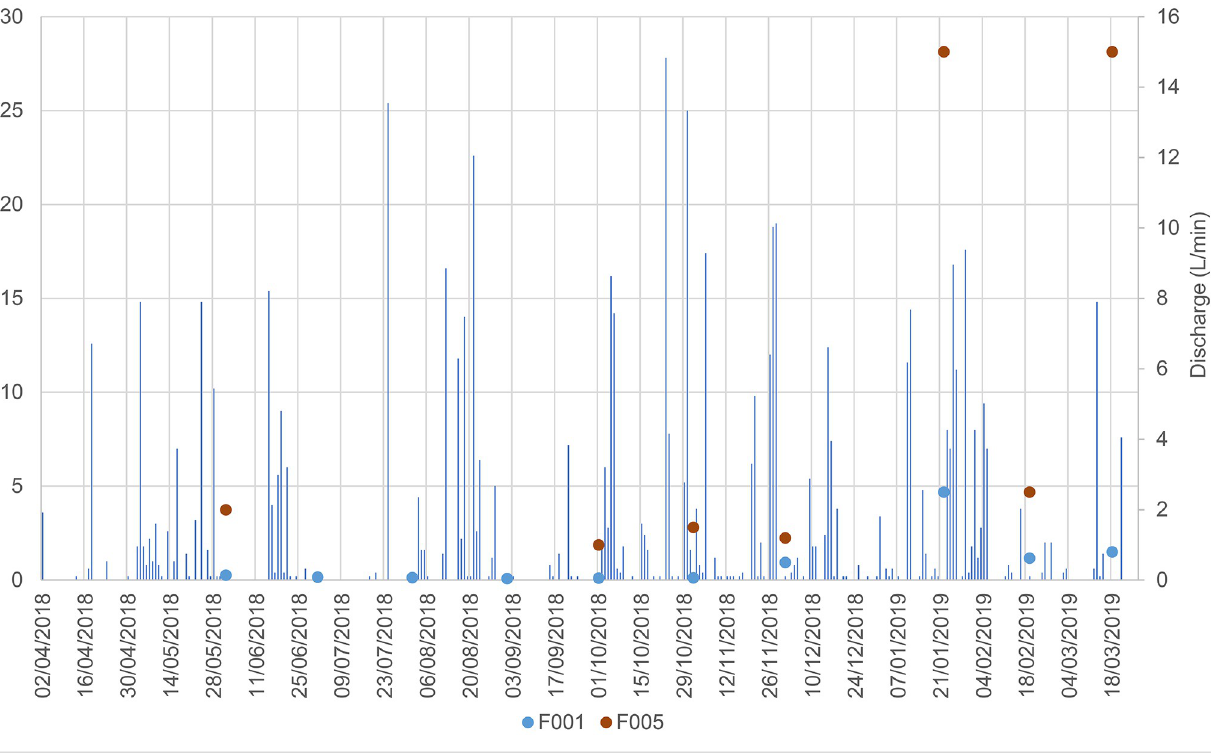
PLOS ONE | https://doi.org/10.1371/journal.pone.0268252 May 6,